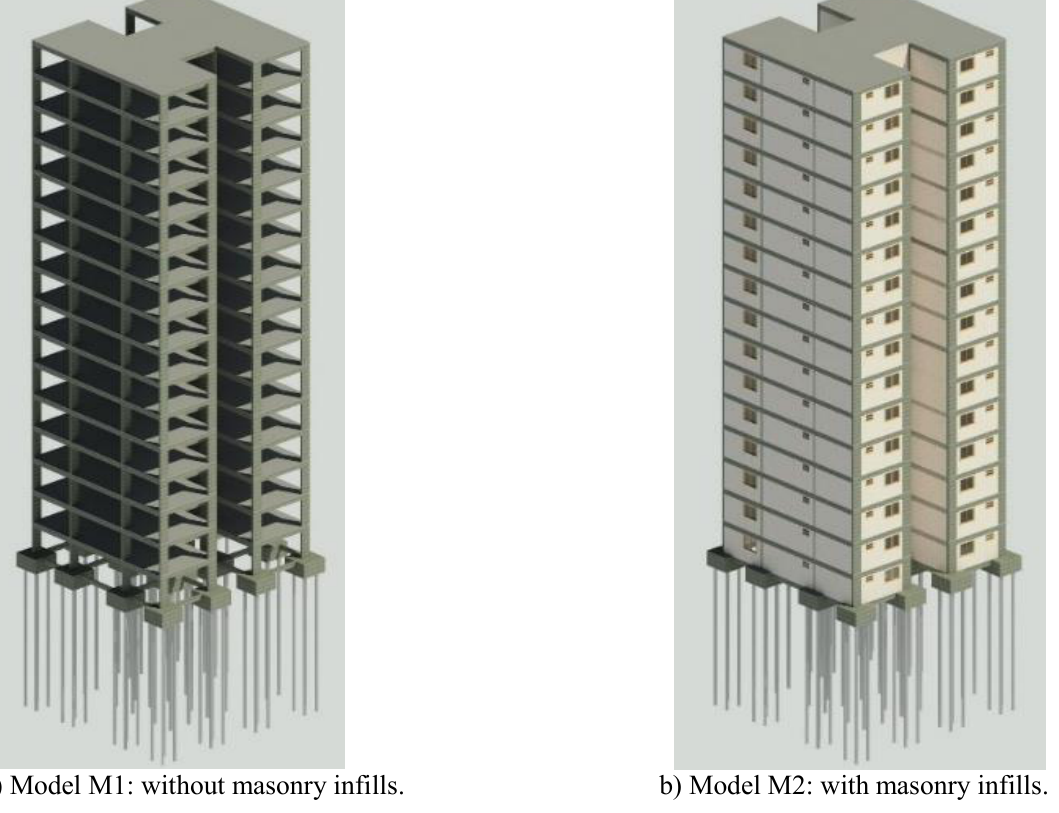
Fig. 3. Structural models of the building consisting of sixteen floors: Models M1 e